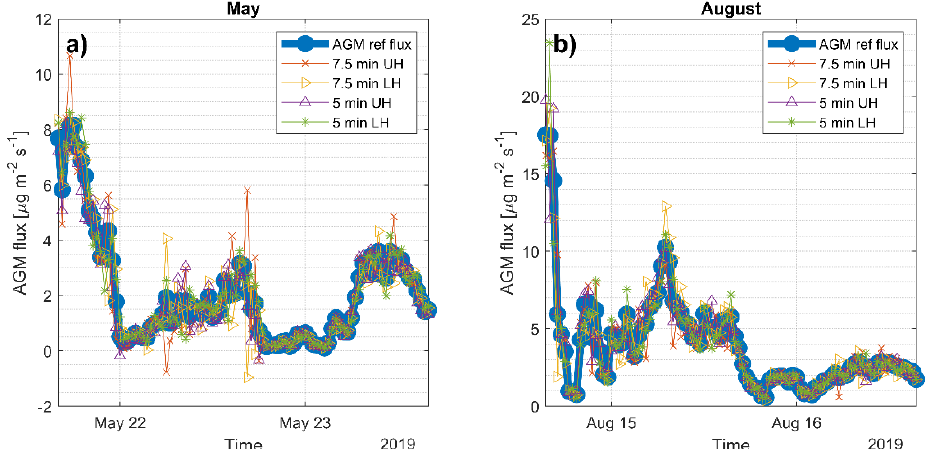
Figure 1. Time series of the reference and simulated AGM fluxes for 48 h in ( a ) May and ( b ) August. The thicker blue line is the reference standard AGM flux.